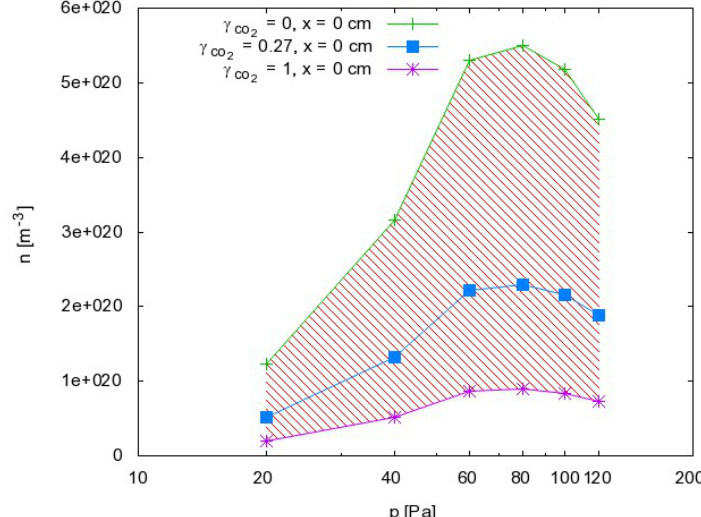
Figure 8. Oxygen atom density versus pressure at 0 cm. The shaded area represents the values that are theoretically possible when taking into account all values of the recombination coefficient. The lowest curve represents the lower limit when the recombination coefficient is 1, and the upper curve represents the upper limit when the recombination coefficient is 0. The curve in the middle represents the O atom density for γ = the most probable value for the recombination coefficient ( i.e ., 2 CO